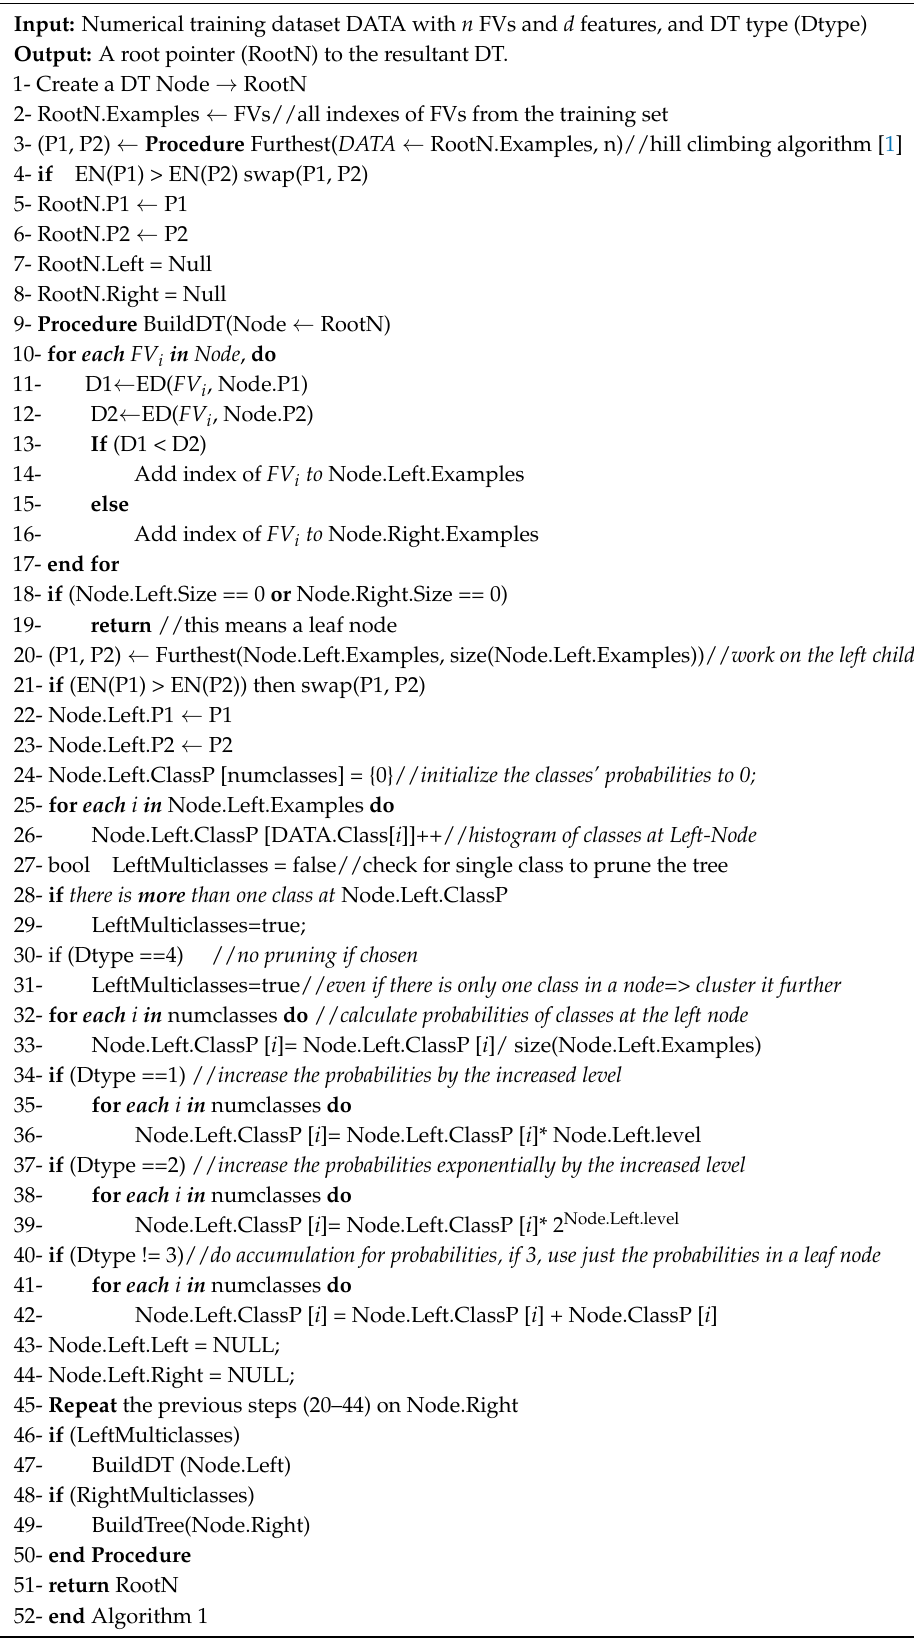
Algorithm 1. Training Phase (DT building) of